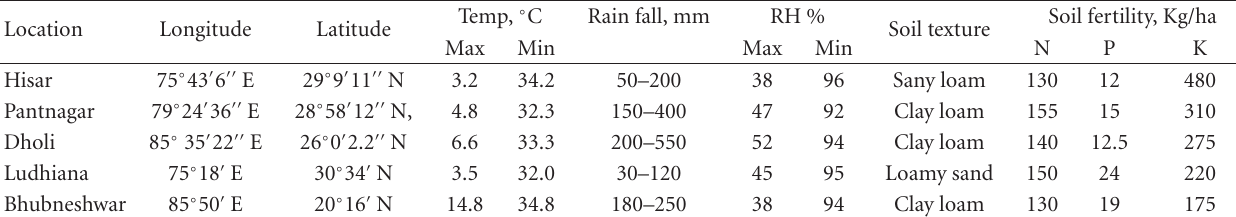
Table 2: Agroclimatic conditions of various locations during mustard crop season. Location